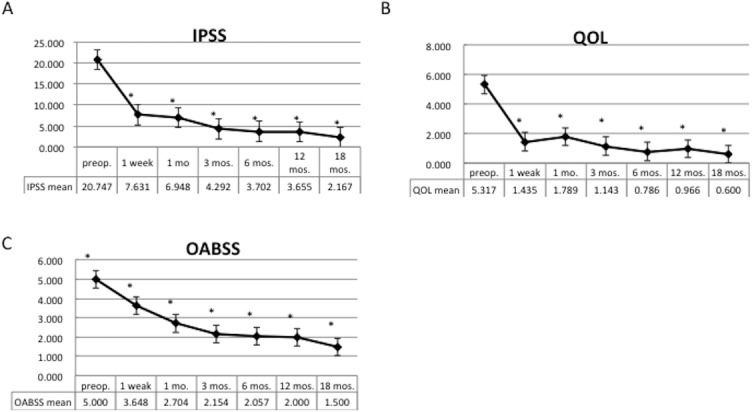
Longitudinal change in IPSS (A), QOL score (B), and OABSS (C).There was significant improvement 1 week after surgery (*: p<0.05 Dunnett's test, compared with baseline). Note that the improvement of the OABSS is slower than the IPSS score.